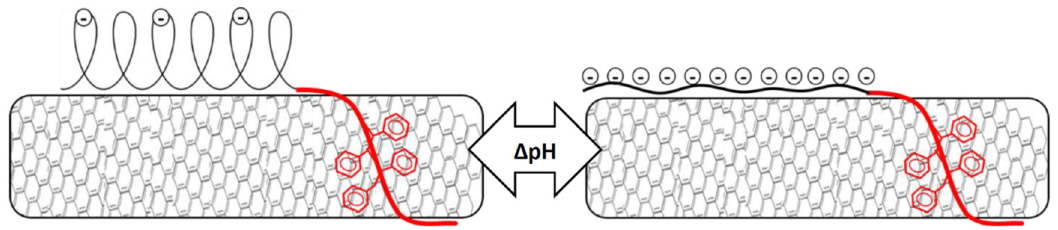
Figure 6. Schematic visualization of the consequences of pH change. The conformation of PAA changes from globular to rod-like resulting in reduced steric hindrance between the nanotubes.